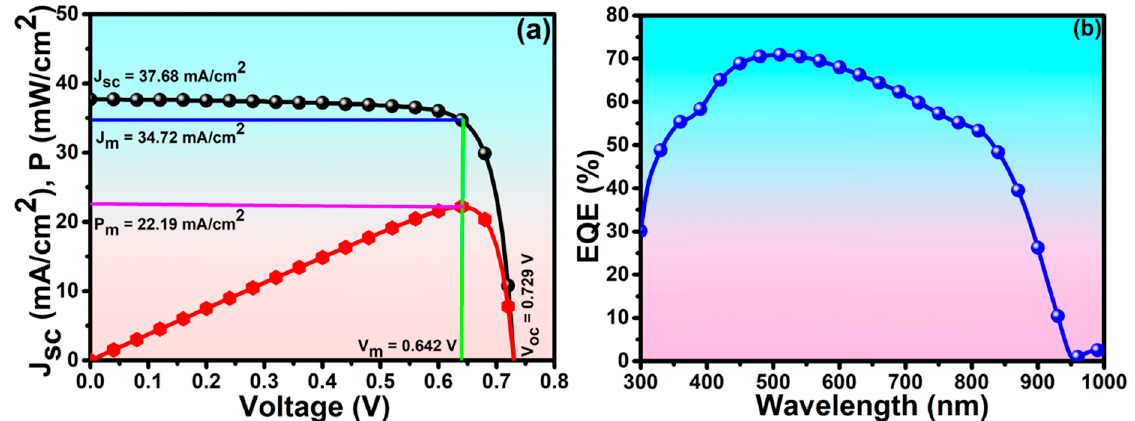
Figure 7. Analysis of ( a ) I, P ‐ V curve and ( b ) EQE of the InGaN solar cell. Table 2. Summary of optimized parameters of the InGaN solar cell.